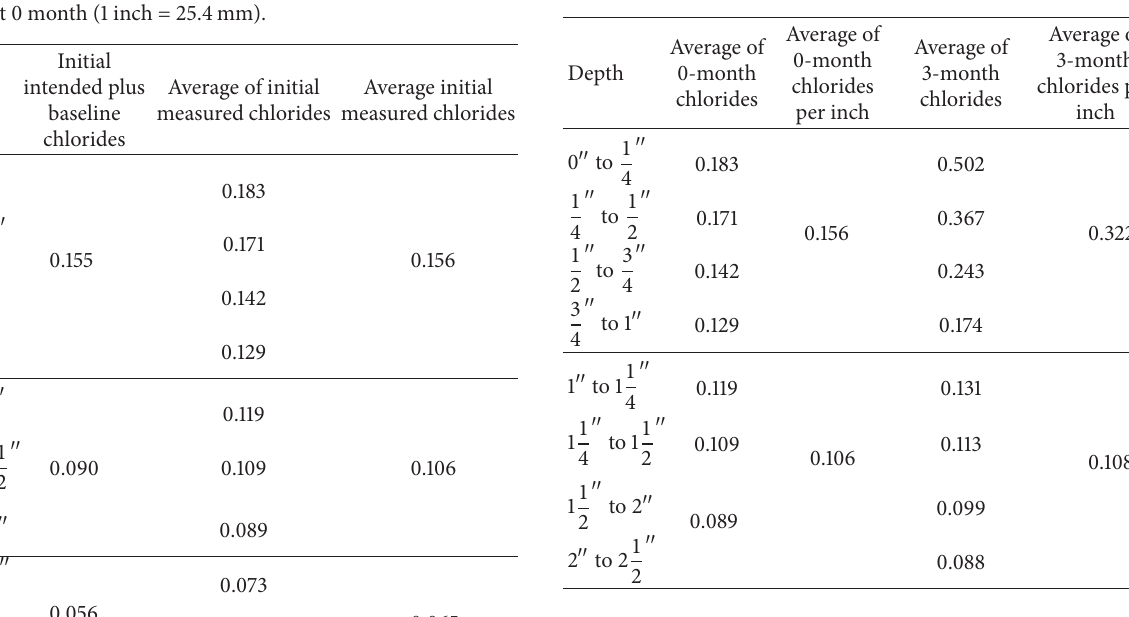
Table 5: Comparison of average acid-soluble chloride contents